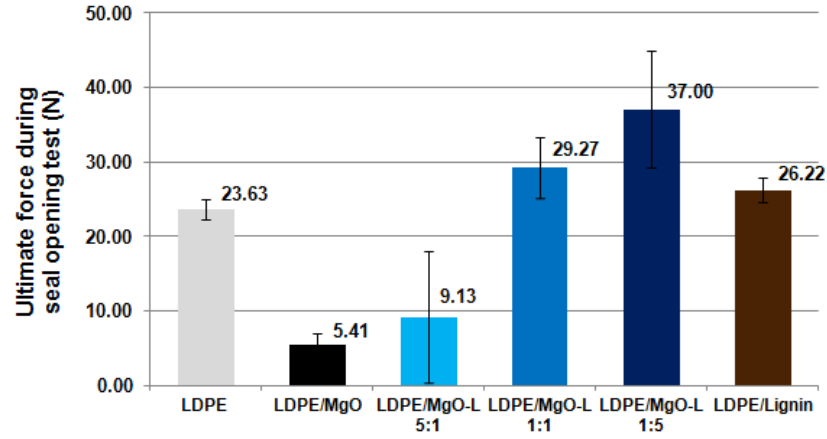
Figure 6. Comparison of the seal open force for tested materials.